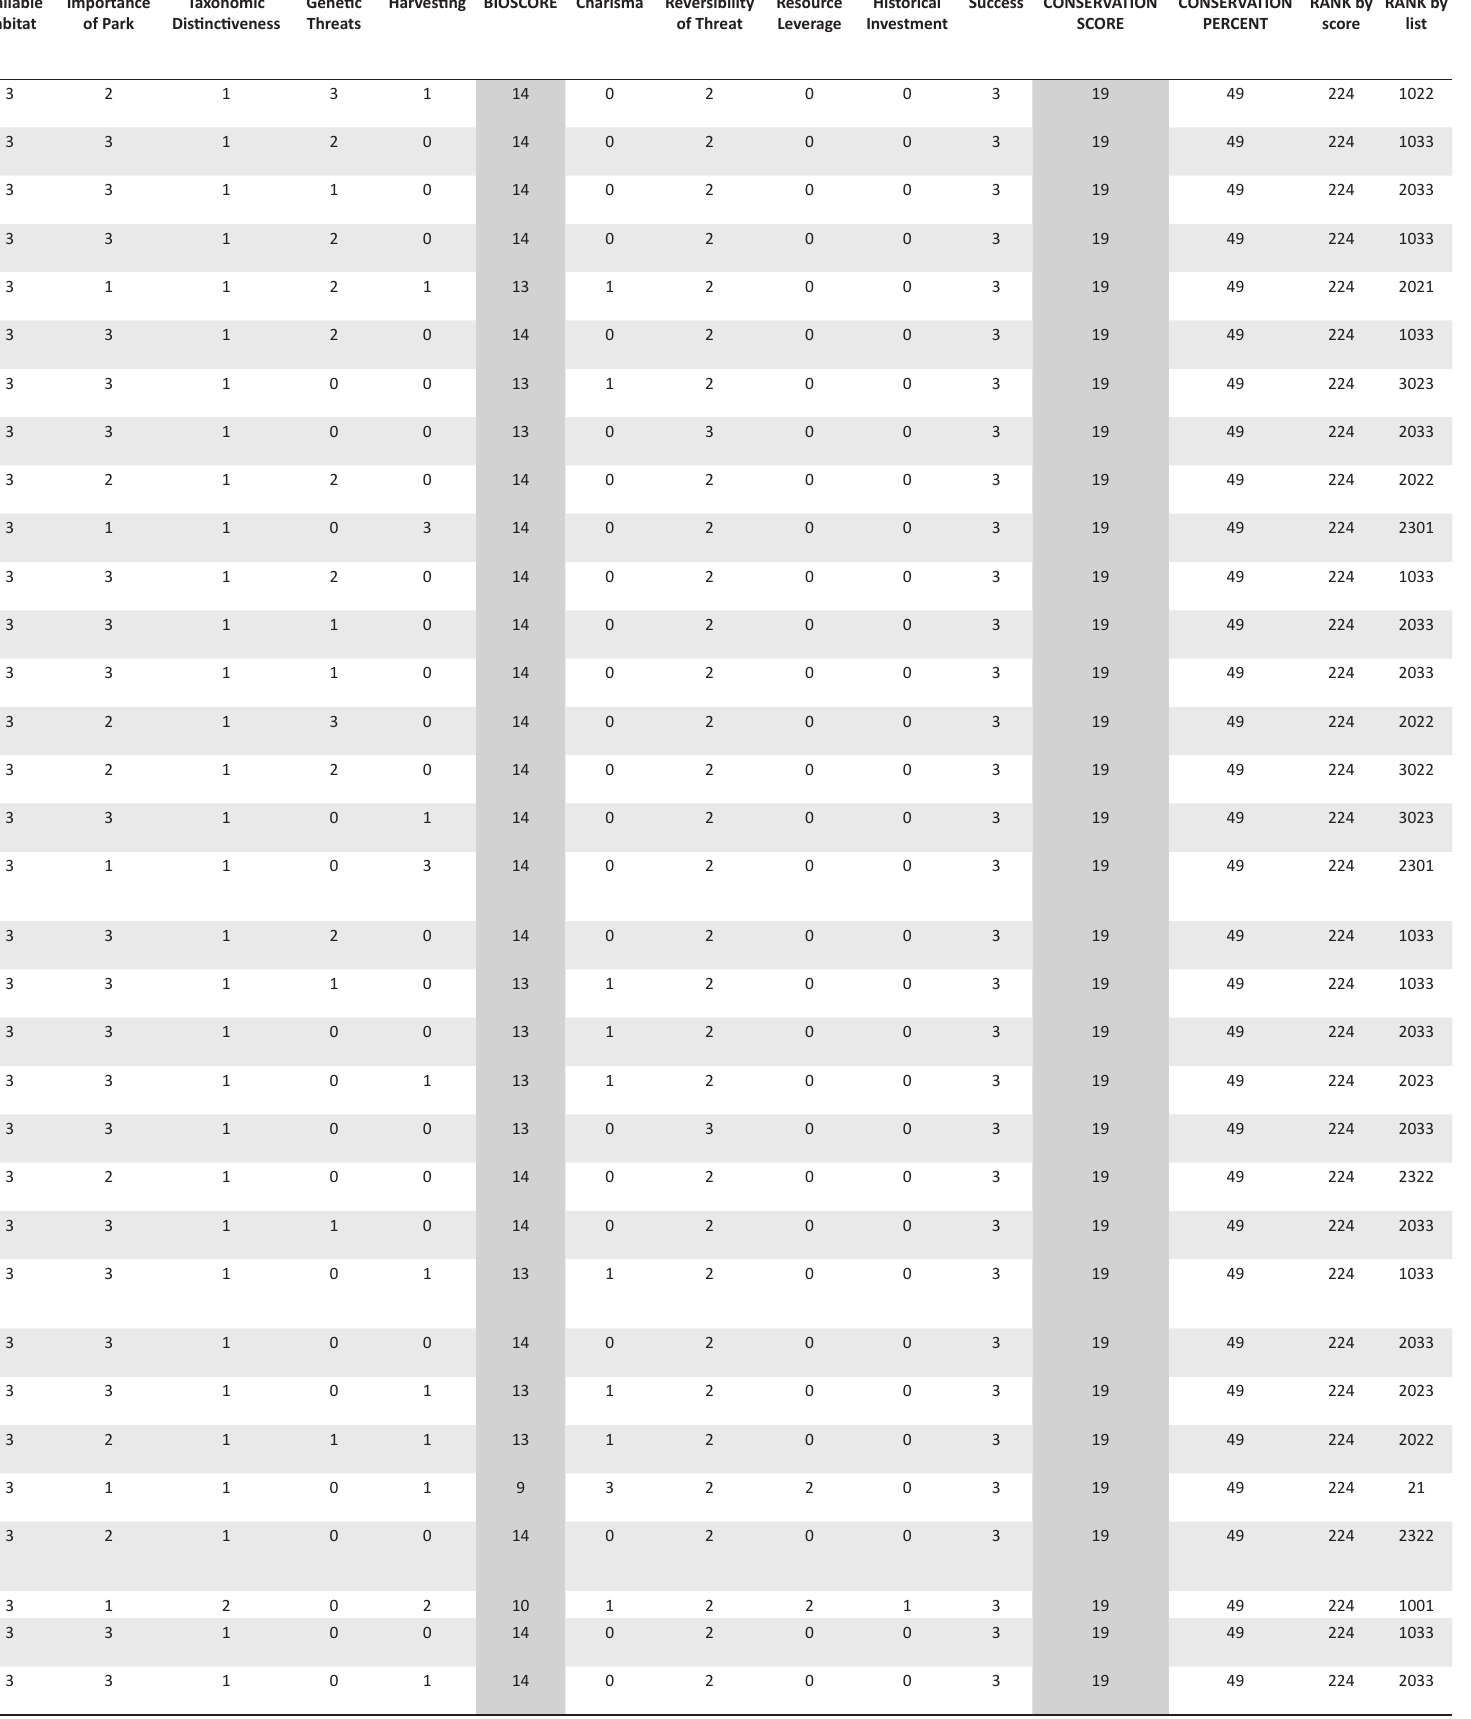
Online Appendix Table 1 (Continues...): List of species of Special Concern in the Table Mountain National Park and associated scores